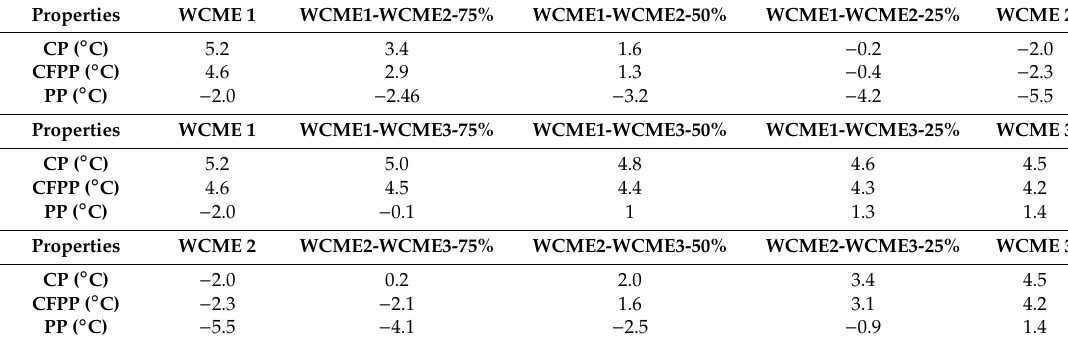
Table 7. Cold flow properties of all biodiesels.